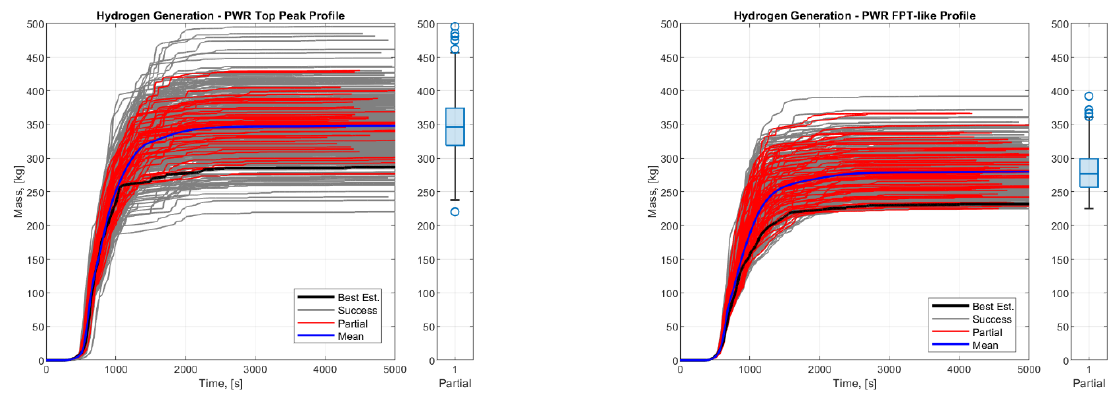
Figure 8. Hydrogen generation for PWR reactor. ( Left )—peaked power profile. ( Right )—FPT-like profile. Best estimate case (black line), mean value (blue line) based on interpolation and extrapolation for both fully and partially successful cases, fully successful cases (grey lines), and partially successful cases (red lines). Partially successful are cases that converged after the time limit—the 2500 s for PWR (394 ( left ) and 398 ( right )). Box-charts are presented with the central bar being the median value for FoM, while the lower and upper quartiles (25–50%) are presented by a box, and the minimum and maximum values that are not outliers are presented by black whiskers and outliers with blue circles.